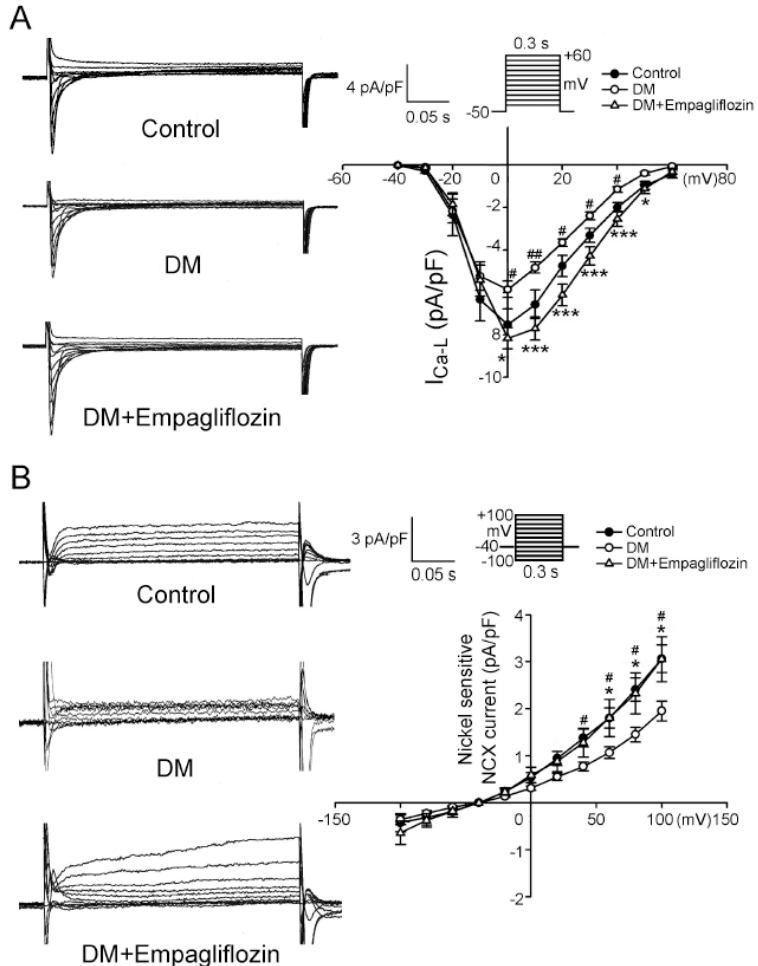
Figure 3. L-type calcium channel (I Ca-L ) and Na + -Ca 2+ exchanger (NCX) current of ventricular myocytes from control, diabetes mellitus (DM), and empagliflozin-treated DM (DM + empagliflozin) rats. ( A ) Representative tracings of current and I-V relationship of the I Ca-L of ventricular myocytes from control ( n = 11), DM ( n = 14), and DM + empagliflozin ( n = 21) rats. ( B ) Representative tracings of current and I-V relationship of the NCX current of ventricular myocytes from control ( n = 11), DM ( n = 13), and DM + empagliflozin ( n = 8) rats. n = number of cardiomyocytes isolated from those rats; # p < 0.05 vs. the controls; ## p < 0.01 vs. the controls; * p < 0.05 vs. DM + empagliflozin rats; *** p < 0.005 vs. DM + empagliflozin rats.